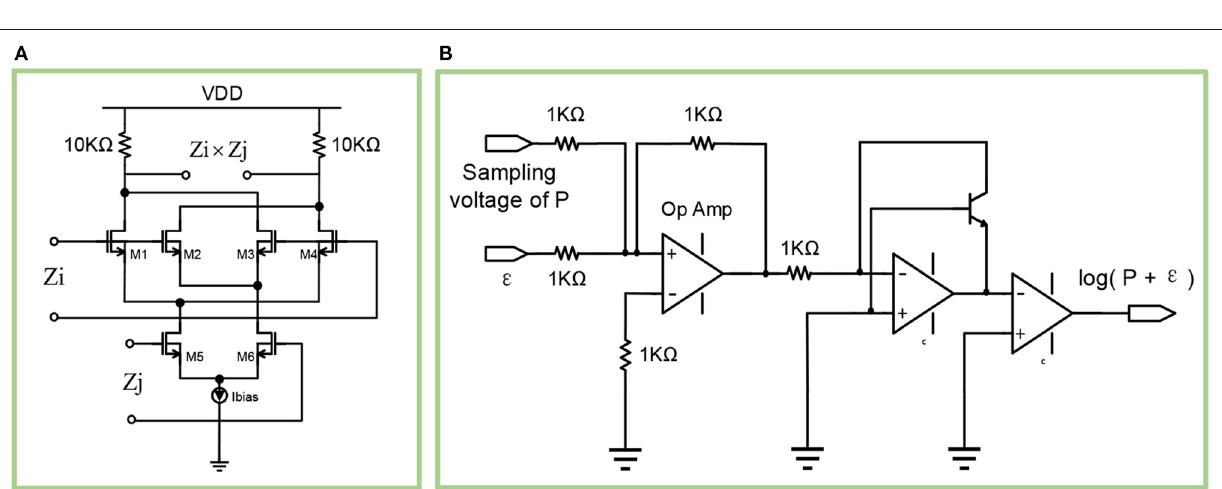
FIGURE 7 | (A) The diagram of the sample-and-hold circuit. (B) The switch between the sampling state and the holding state, controlled by switches S1, S2, and S3.